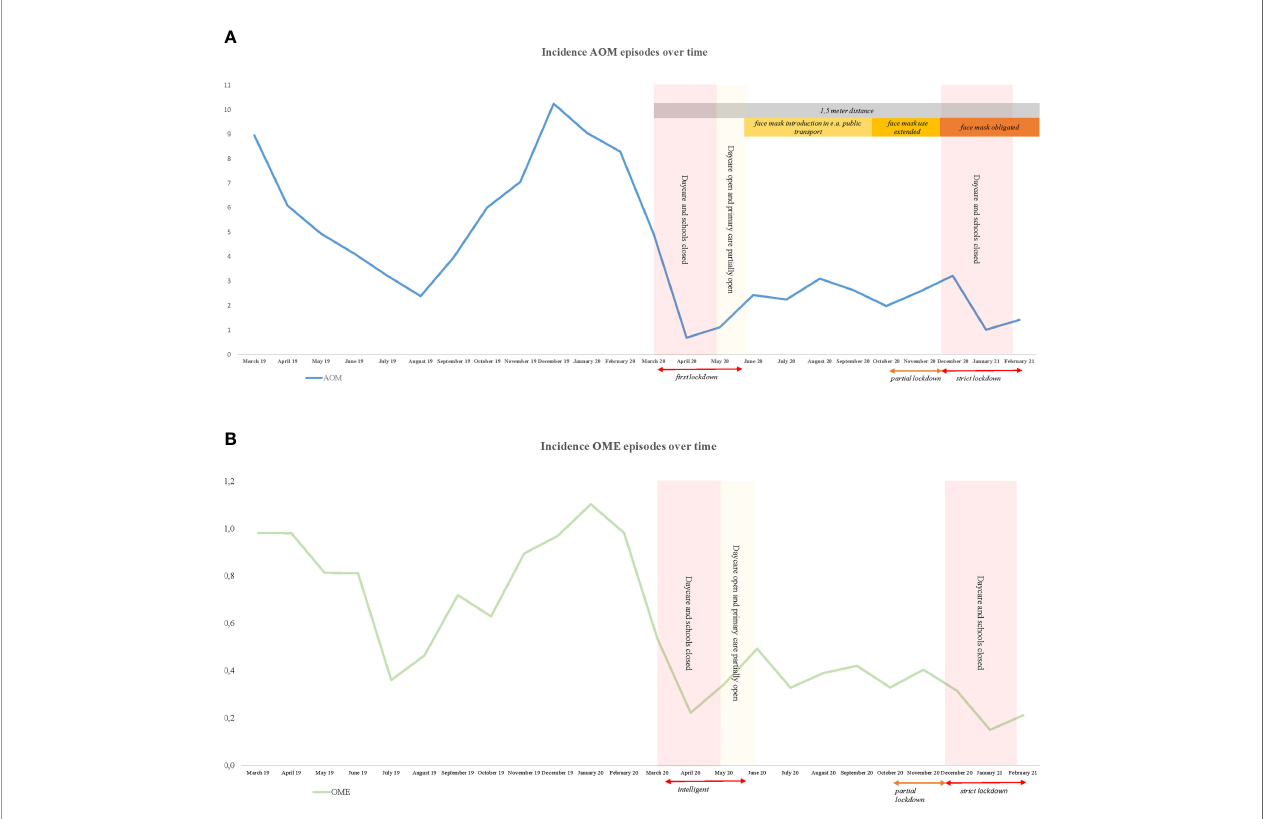
FIGURE 2 | Incidence AOM and OME episodes per 1000 childmonths and government restrictions. (A) AOM, (B)